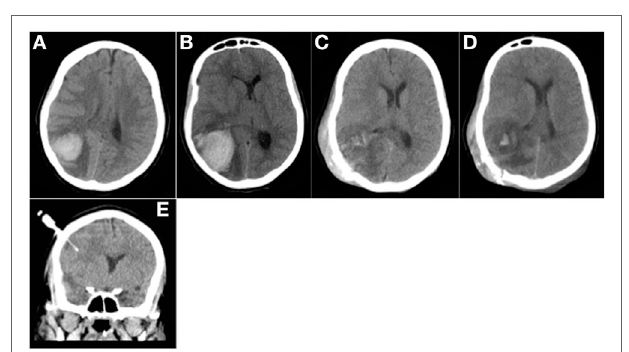
FIgURe 4 | Patient 2. CT head (a,B) prior to surgery: (a) Day 1: 36 mL parieto-occipital hematoma with perilesional edema and slight mass effect. (B) Day 3: significant hematoma expansion (hematoma volume measured at 50 mL) and increased mass effect. CT head (C–e) after surgery: (C) Day 5; the day after surgery: hematoma evacuation; decreased mass effect; subcutaneous hematoma occurring during surgery. (D) Day 10: no rebleeding was noted. (e) Day 10: no hemorrhage was observed around the intraparenchymal probe (intracranial pressure monitoring).